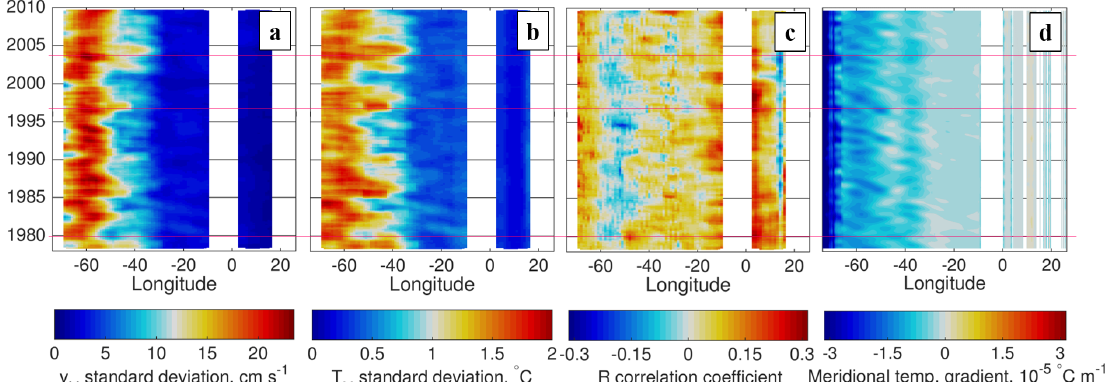
σ T R , where σ v and σ T are M M M M